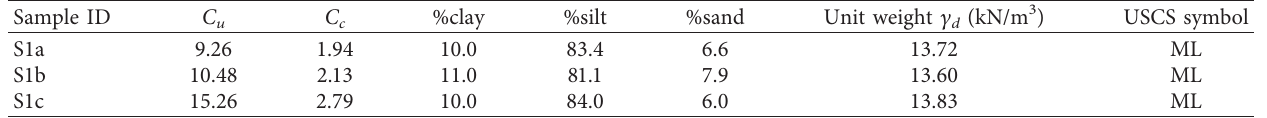
Table 1: Physical properties of Lantian loess.